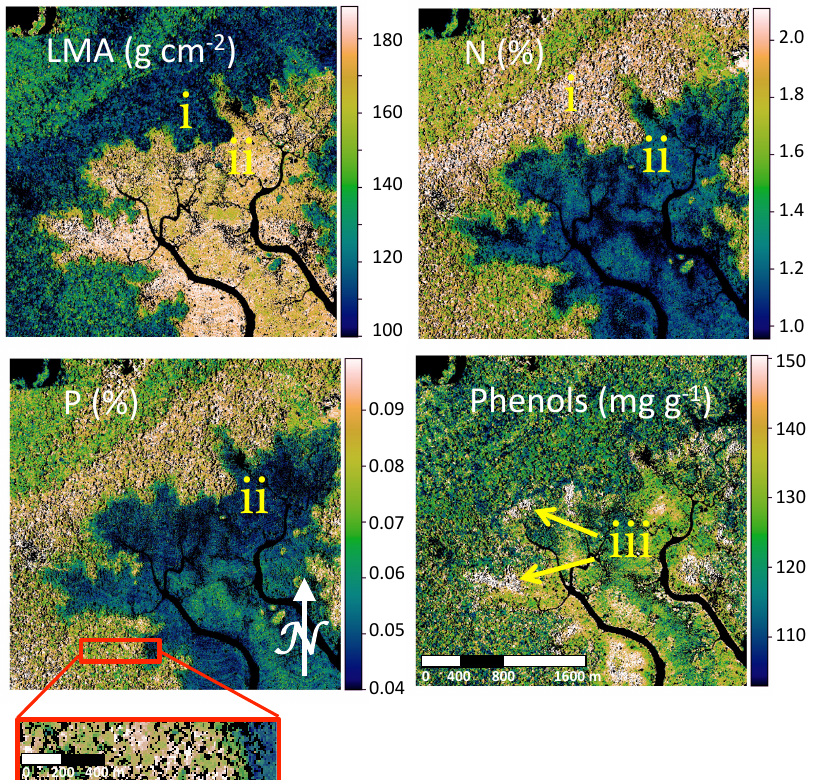
Figure 6. Maps of predicted foliar traits (leaf mass per area (LMA); total nitrogen (N); total phosphorous (P); phenols) are shown for an example region of the Sepilok Forest Reserve. Color bars represent the linear scale for trait values. Nonvegetated pixels are shown in black (see zoom window). Mapped traits follow known patterns in this example landscape. Areas of low LMA and high N (i) are higher fertility alluvial forests. Areas of low N and P with high LMA bordering the inlets are mangrove forest (ii). Phenols are higher in transitional forests (iii).